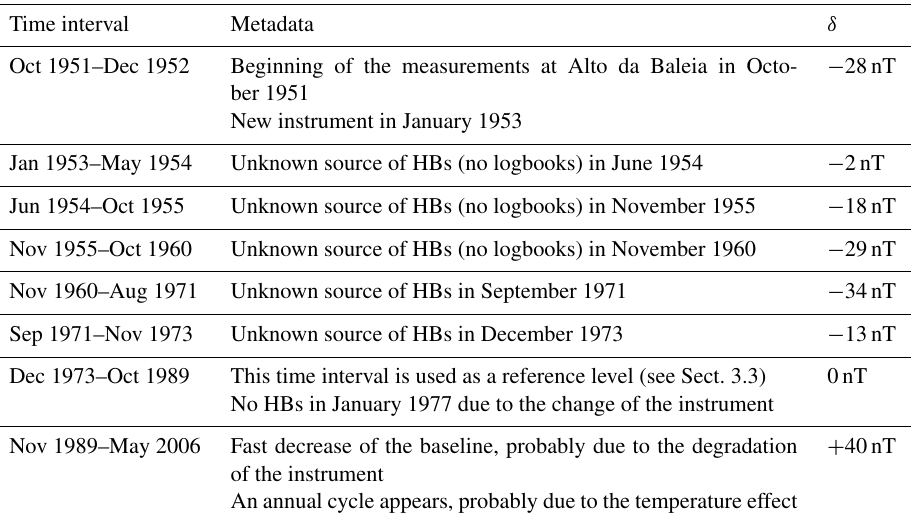
Table 3. Metadata for the Z data set at the Alto da Baleia site: dates of the instrument replacements, relocations, changes to the measurement and calculation procedures, etc. Estimated corrections ( δ ) for the COI series for different time intervals are in the third